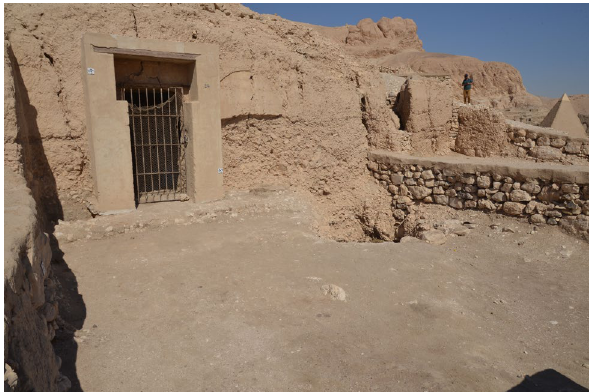
Figure 2 . TT214, tomb of Khawy.